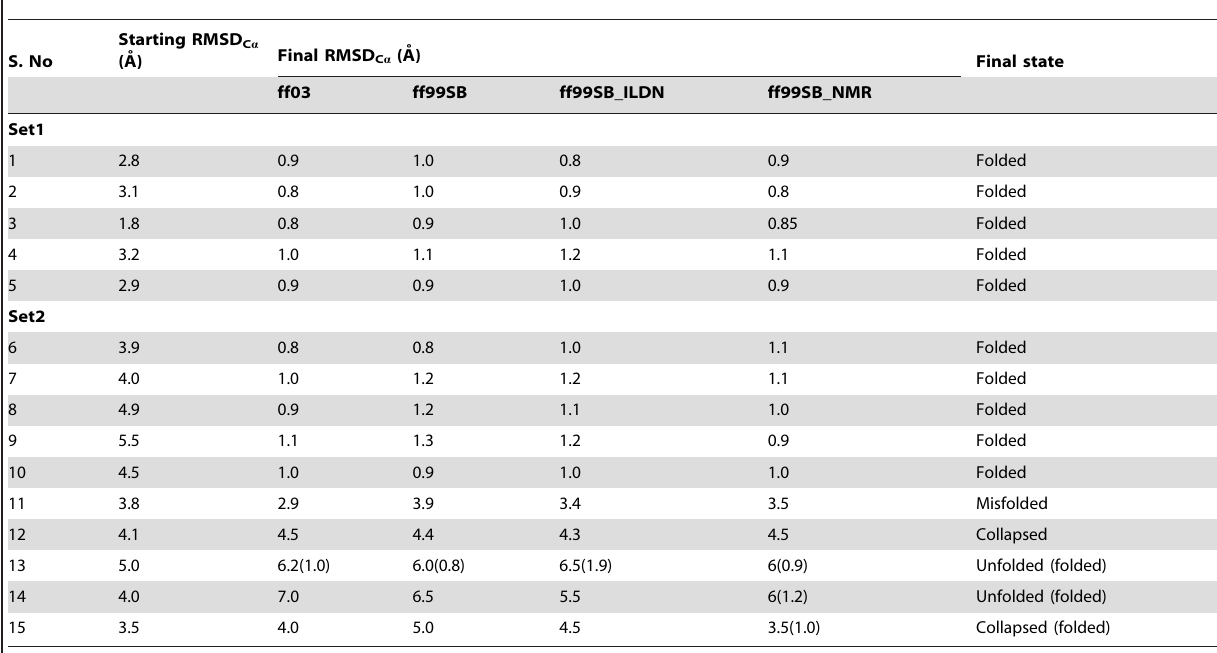
Table 2. Results of simulations starting from different intermediate state of Trp-cage.